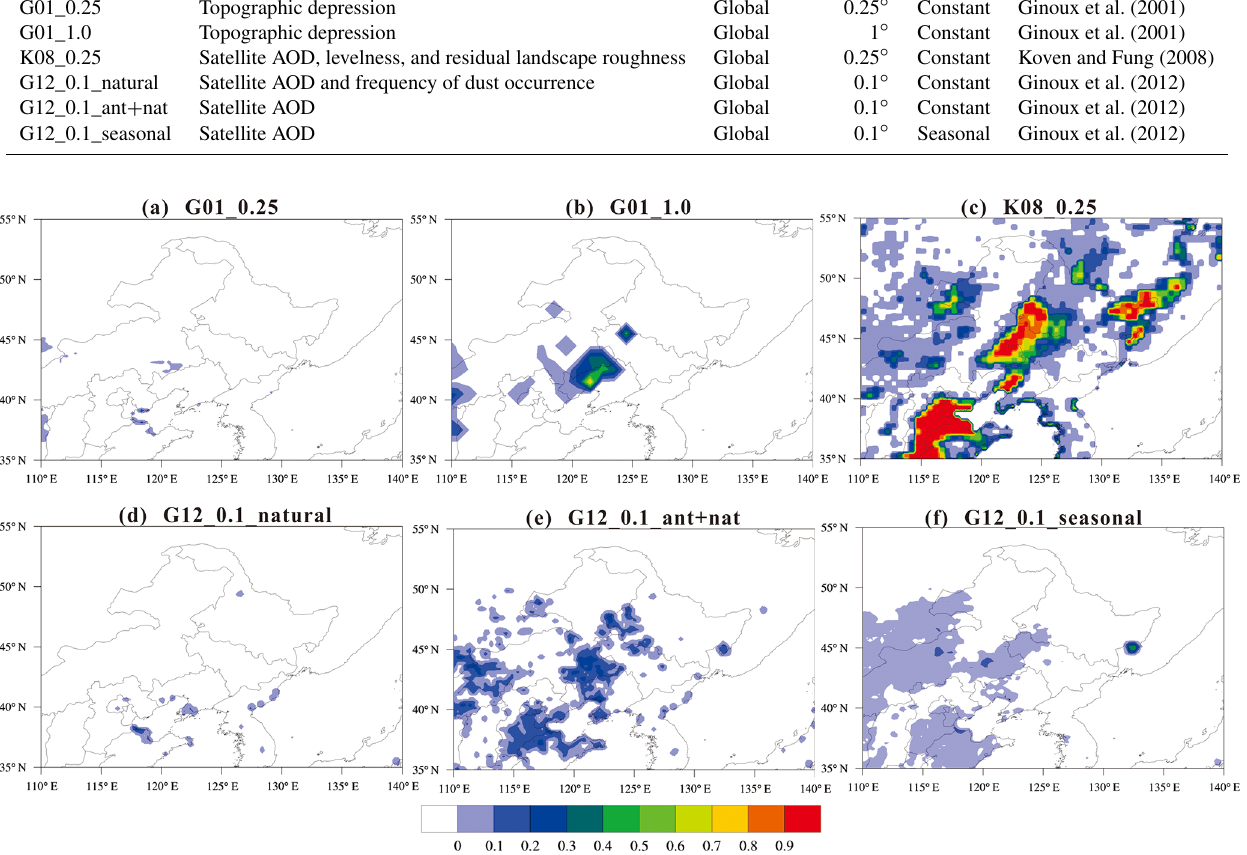
Figure 3. Dust source maps in NEC. (a) G01_0.25, (b) G01_1.0, (c) K08_0.25, (d) G12_0.1_natural, (e) G12_ 0.1_ant_nat, and (f) G12_0.1_seasonal